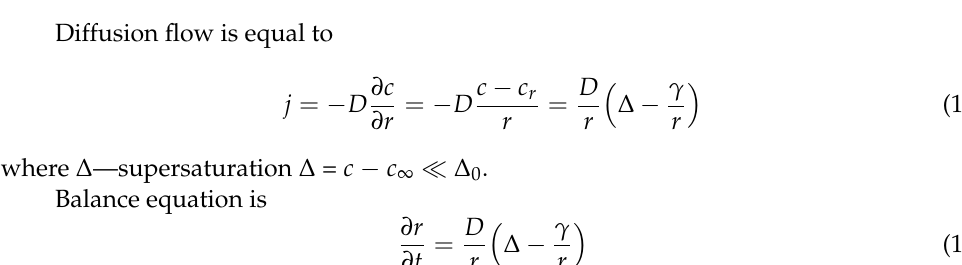
where 𝛥 —supersaturation 𝛥 = c − c ∞ << ∆ 0 . Balance equation is Balance equation is Balance equation is